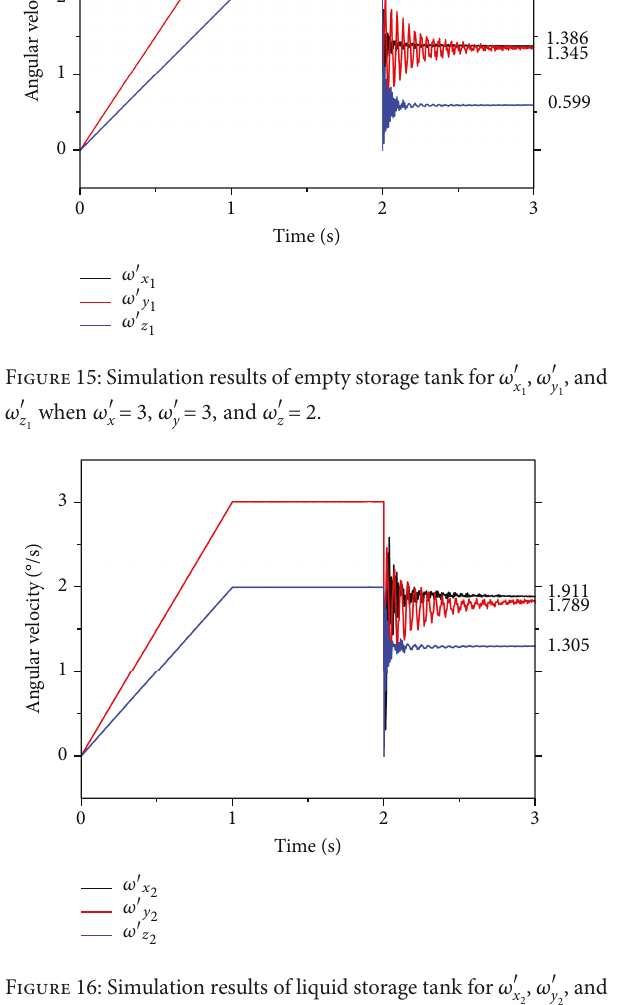
′ = 3 , ω ′ = 3 , ω ′ = 2 , and ν = 100 . x y z